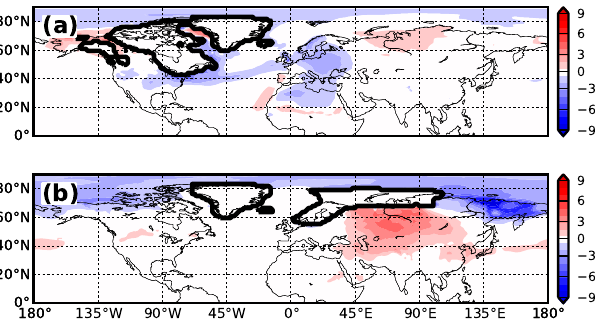
Figure 8. Same as in Fig. 7c for the MIS 4 Laurentide Ice Sheet to- pography in the upper panel and the Eurasian Ice Sheet topography in the lower panel.